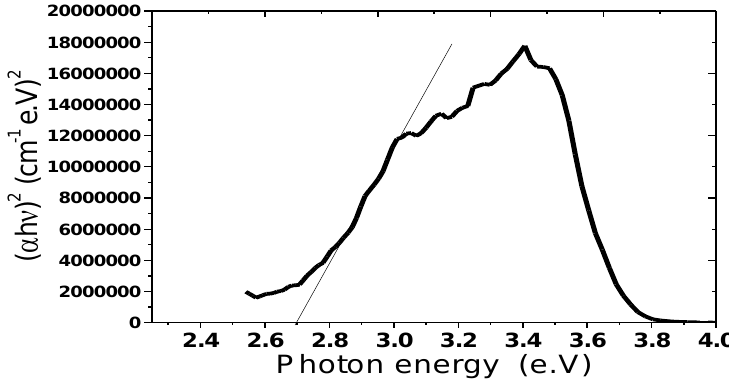
Figure 3: Energy gap assessment for Vitamin D